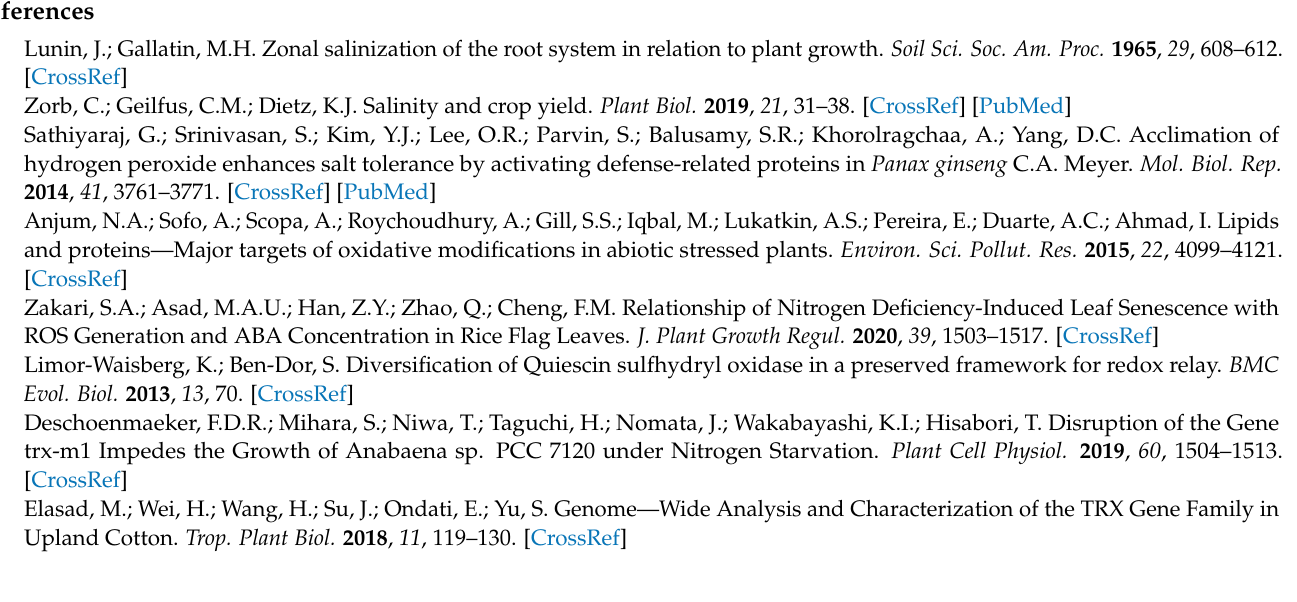
acid sequence. Figure S2. Phylogenetic tree of TRX . Figure S3. Three-dimensional model of the MsTRX protein. Table S1. List of primers in this